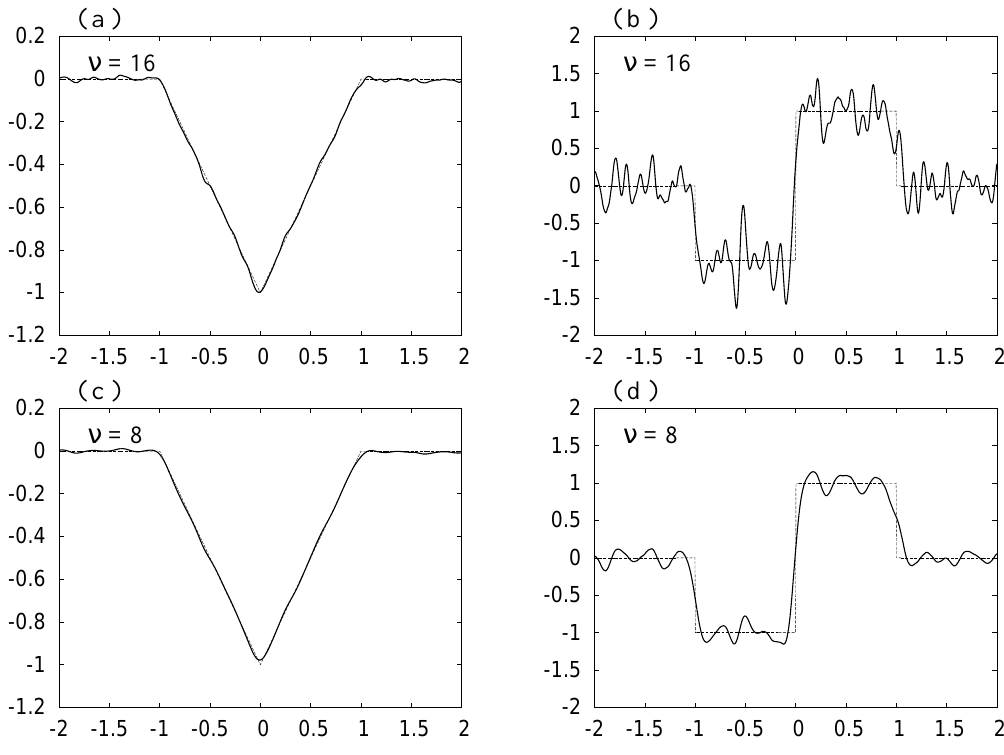
f ( x ) ; ( b ), ( d ), ( f ): ( M ν 1 ,ϵ f ( x ) and ( M ν 1